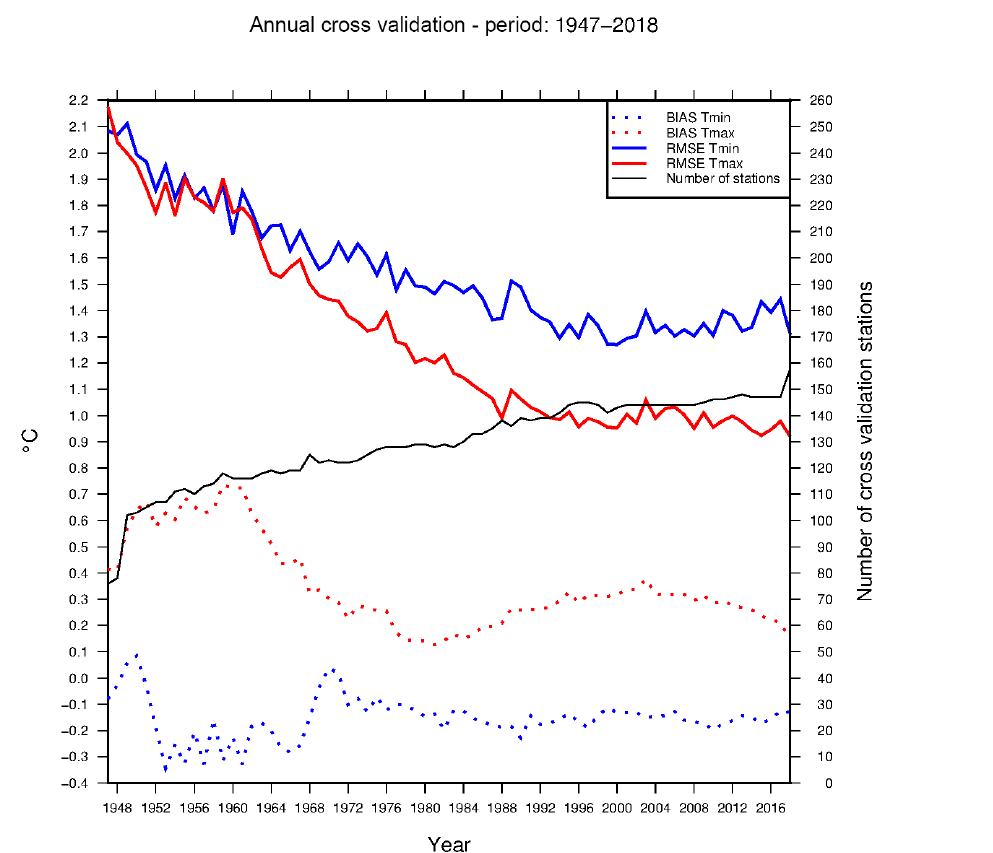
Figure 1. Evolution of bias (dashed curve) and RMSE (plain line) from 1947 to 2018 for minimum (in blue) and maximum (in red) temperatures. The number of stations used for cross validation is represented with the black plain line.